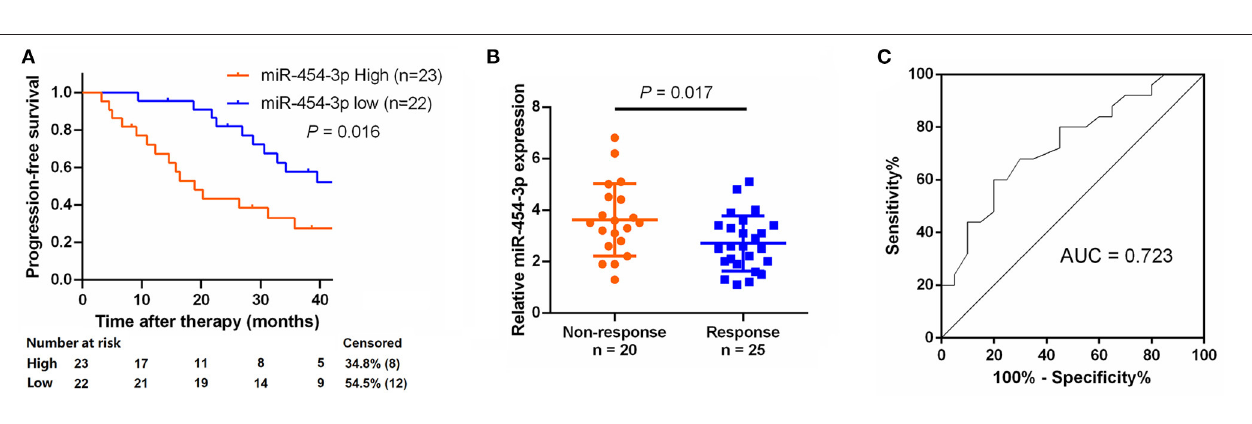
FIGURE 6 | Up-regulation of miR-454-3p reduced the sensitivity of colorectal cancer cells to oxaliplatin in vivo . (A) Tumor xenografts with HCT-116 cells stably transfected with miR-454-3p or negative control. The mice received oxaliplatin every 4 days starting from the 8th day after tumor inoculation. (B) Representative images of dissected tumors in each group. (C) Quantitative RT-PCR analysis of the expression of miR-454-3p in representative tumor tissues. (D) A proposed mechanism of miR-454-3p mediated oxaliplatin resistance. ** P < 0.01, *** P < 0.001.